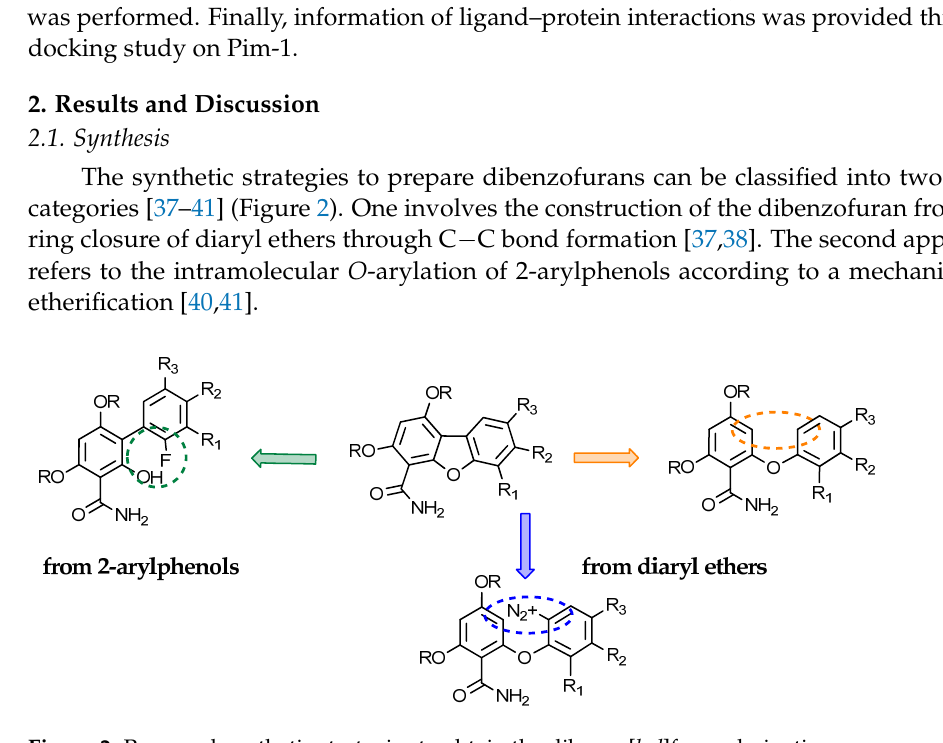
Figure 1. Drug design of the 1,3-dihydroxydibenzo[ b , d ]furan-4-carboxamide scaffold-based deriva- tives.